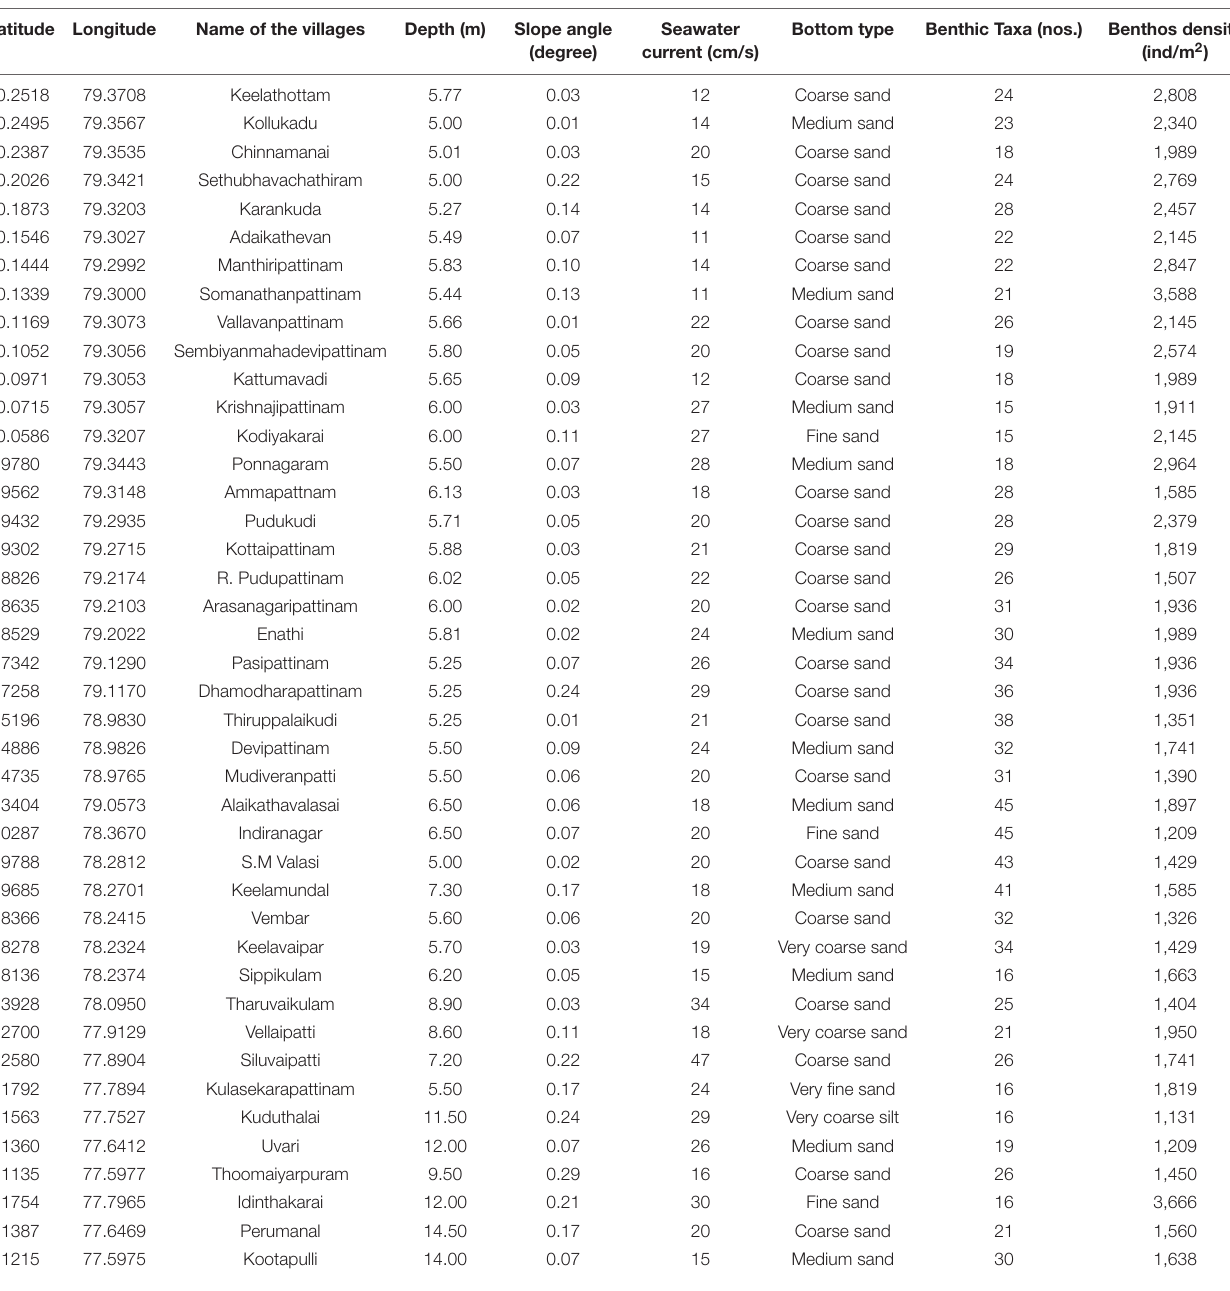
TABLE 3 | Details of the Artificial Reefs deployed locations along the Tamil Nadu coast. Latitude